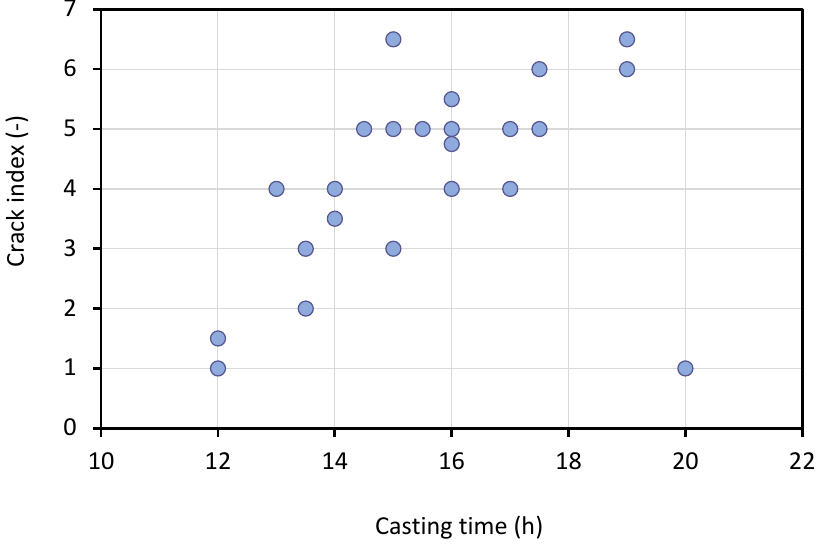
Figure 12. Relation between the crack index and time required for the casting of concrete.